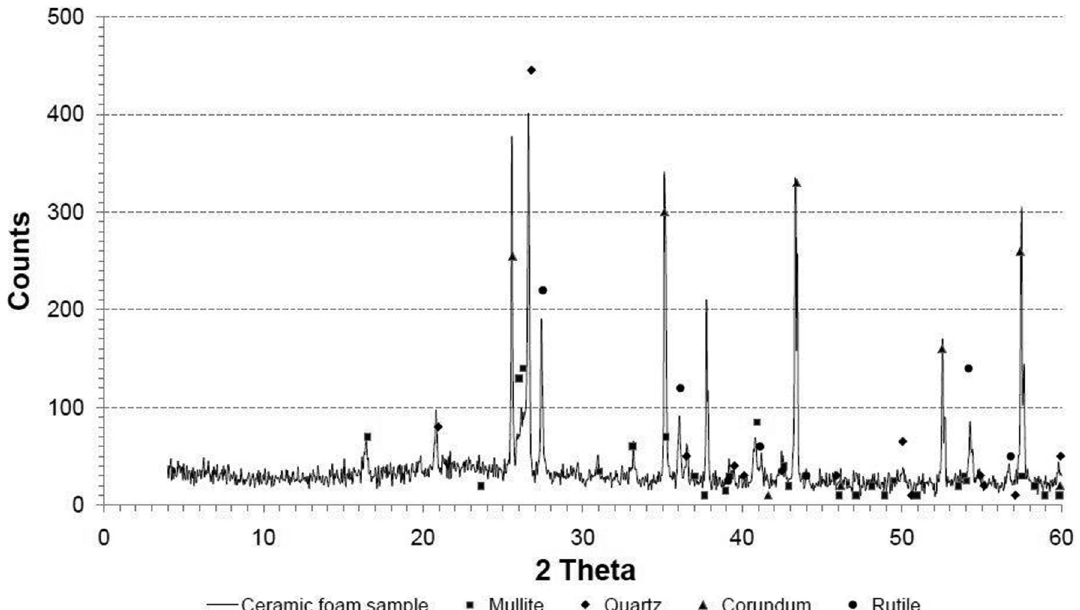
Figure 1. X-ray diffraction of the ceramic foam sample. Type 2Th/Th locked. Start: 4.027°; end: 60.024°; step: 0.05°; step time: 3 s. Major compounds presents are: Corundum (Al 19.4%; and rutile (TiO